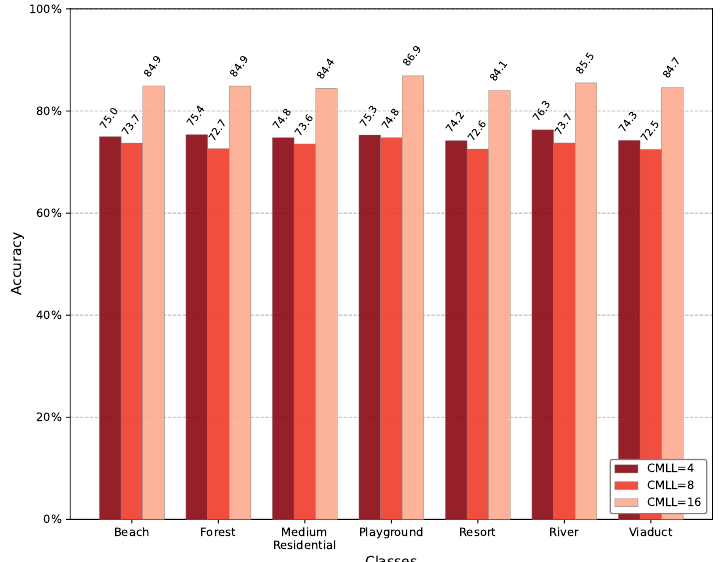
Figure 16. Comparison of class accuracies when different Continual Meta-learning Iteration Lengths (CMLL) are 4, 8, and 16.